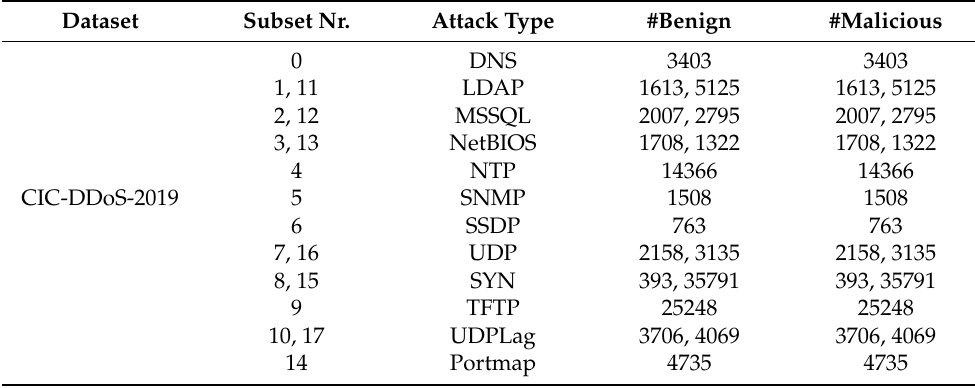
Table 4. CIC-DDoS-2019 Class Label